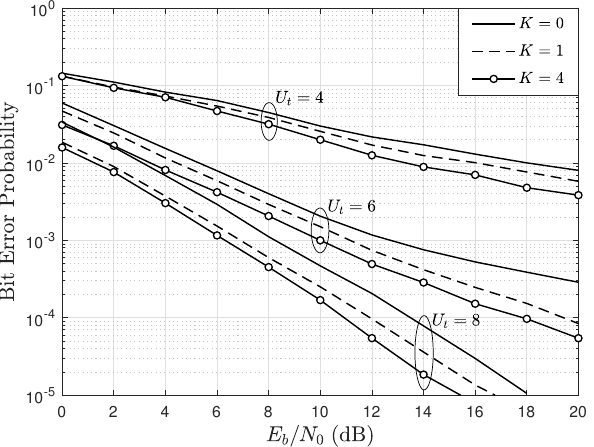
Figure 5. BER as a function of E b / N 0 , parameterized by U t , and by the Rician factor K , considering BPSK modulation, A = 4, U = 4, and e = 0.1.